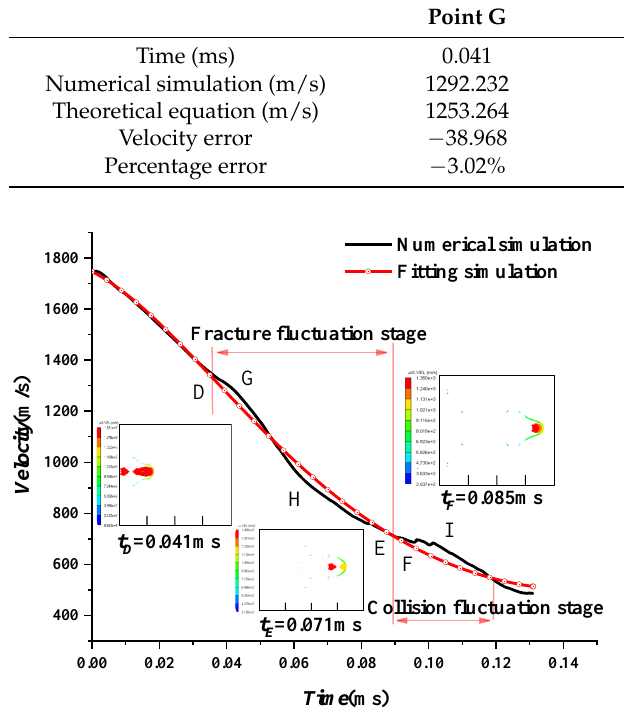
Figure 20. Attenuation curve of the shaped charge projectile entering